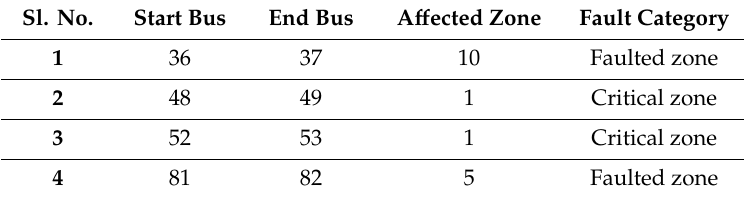
Table 9. Assumed faulted lines of test case